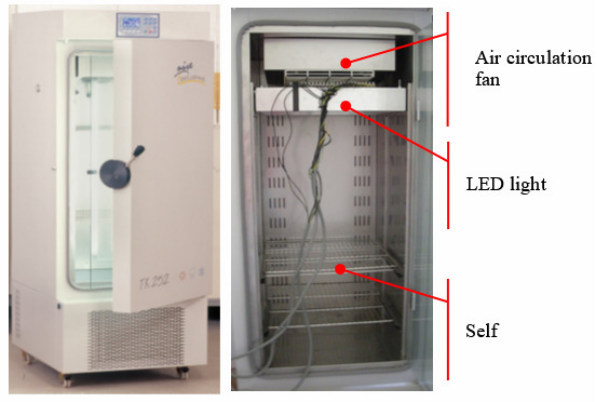
Fig. 1. Plant cultivation cabinet (Nüve, TK252)